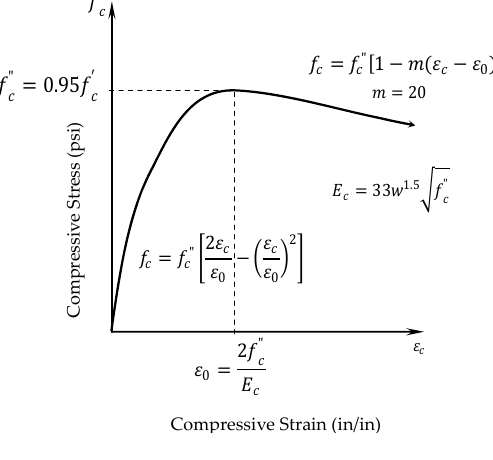
Figure 7. Concrete model.